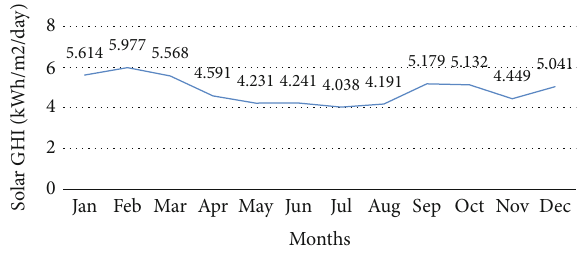
Figure 16: Monthly solar Global Horizontal Irradiation (GHI kWh/m 2 /day) for Kenya.